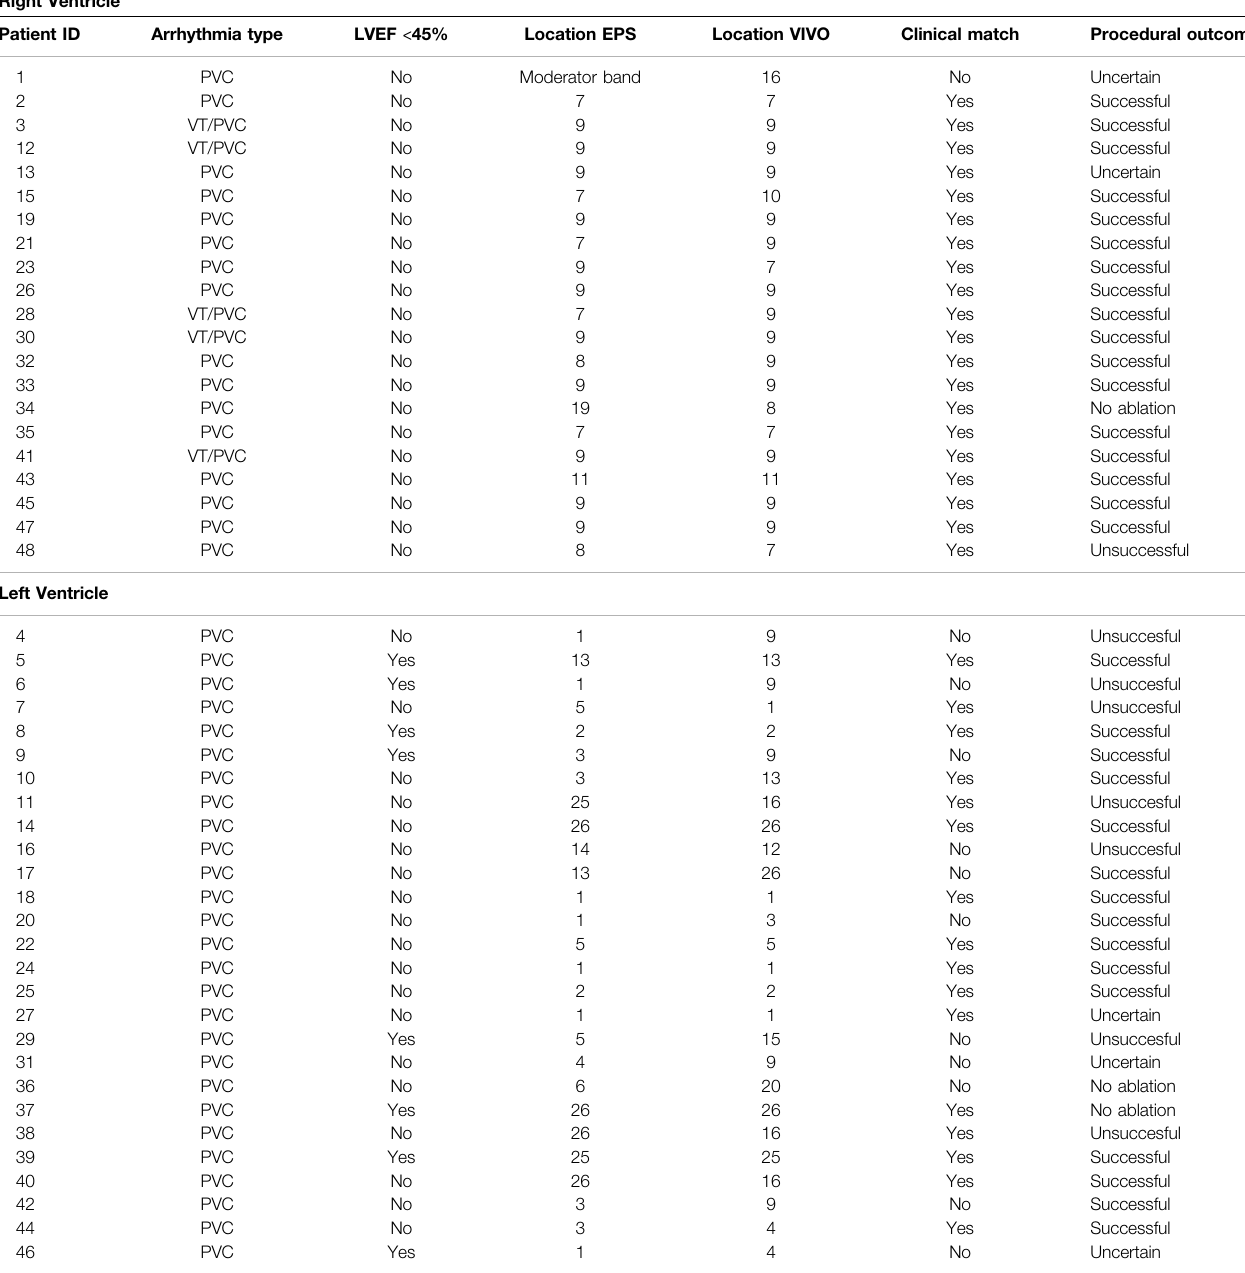
TABLE 2 | Procedural characteristics and matching VIVO maps with invasive localization. Right Ventricle Patient